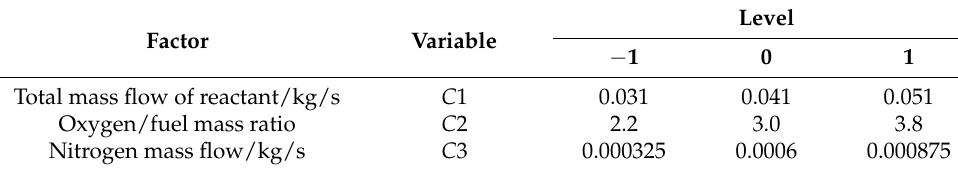
Table 1. Coding and level of influencing factors.